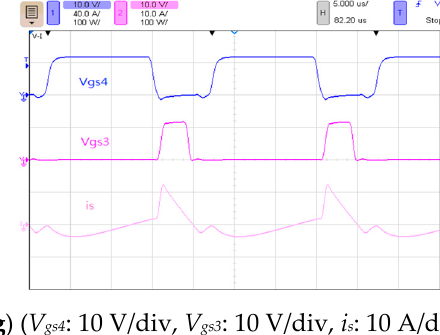
Figure 12. Measured waveforms under Stage 2 at full load: ( a ) switch S 1 waveform, ( b ) switch S 2 waveform, ( c ) primary-side current waveform of transformer, ( d ) charging inductor current waveform, ( e ) switch S 3 waveform, ( f ) switch S 4 waveform, and ( g ) secondary-side current waveform of transformer.